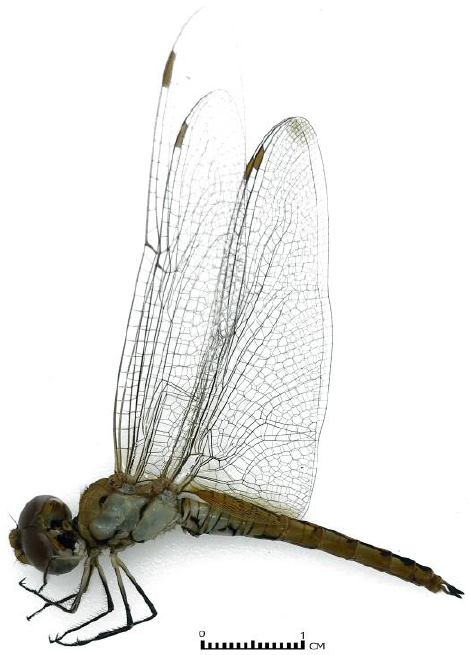
Figure 1. Specimen of P. flavescens (male) was collected from Nankunshan Provincial Nature Reserve, Guangdong, China in June 2021.